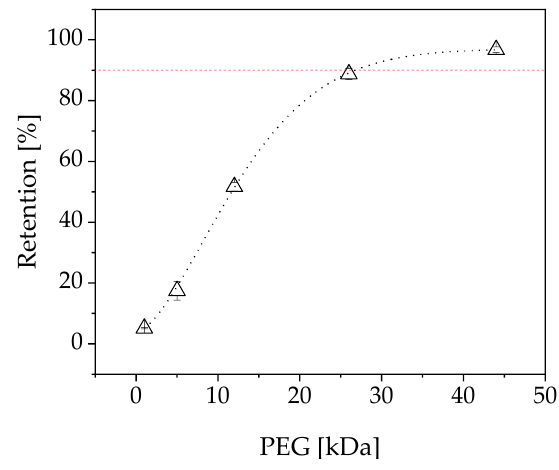
Figure 11. Sieve curve of the used membrane (atech innovations). PEG = polyethylene glycol.